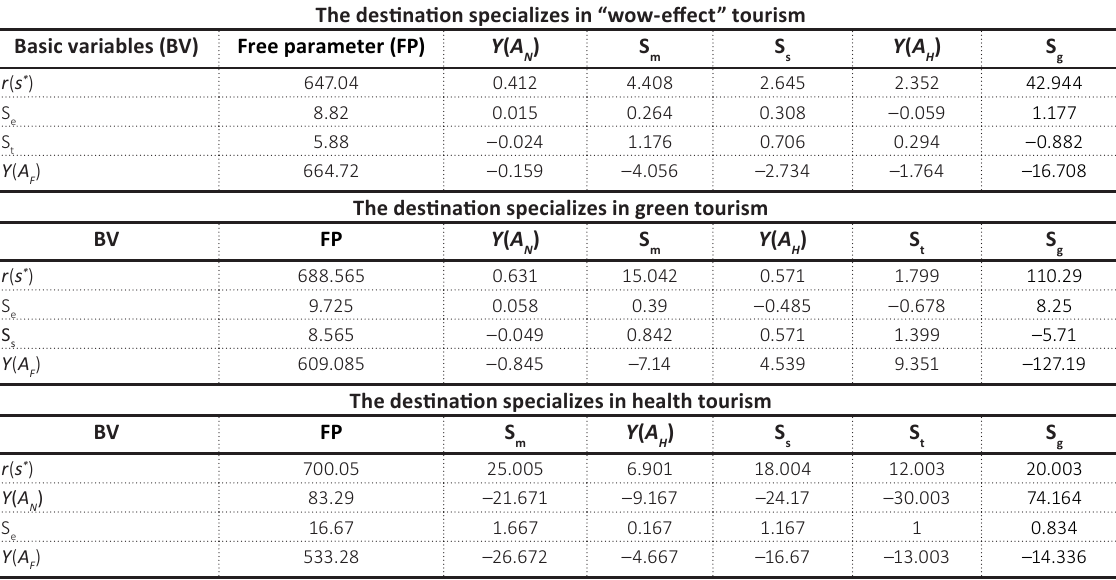
Table 1. Final iteration of the spreadsheet according to the standard record format in the linear programming